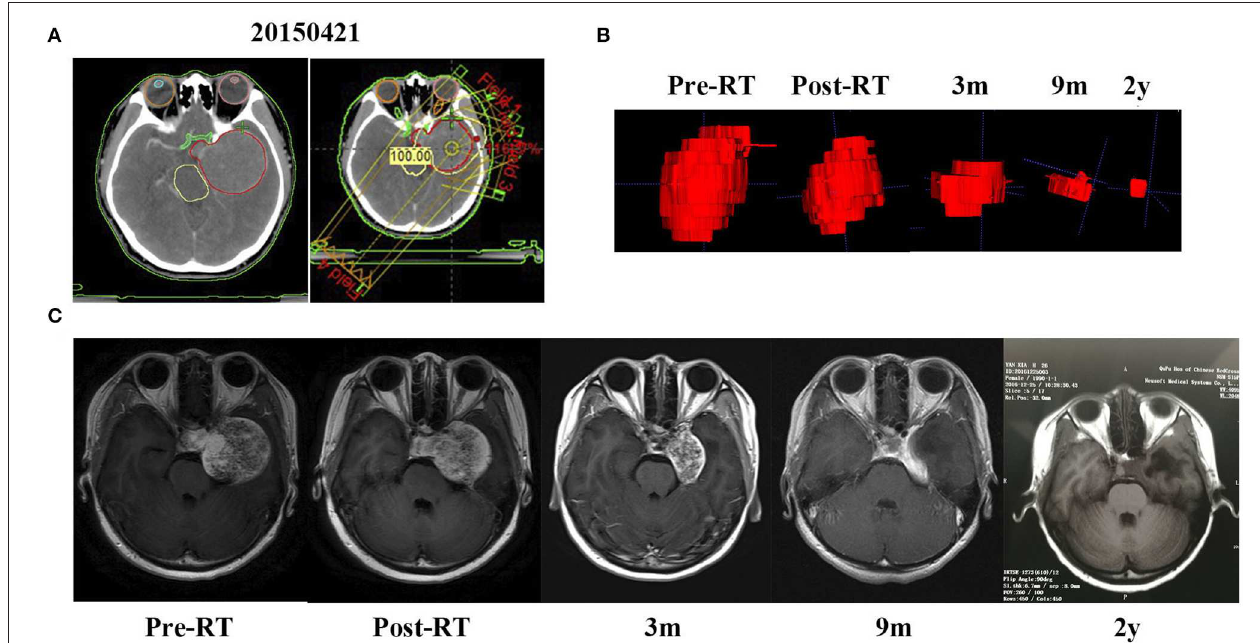
FIGURE 1 | A mass occupying the left cavernous sinus of a 24-year-old woman (patient 1) was shrunk gradually after RT. (A) Treatment plan based on CT scan. (B) The 3D imaging of the mass before RT and at a different time of follow up after RT. (C) MRI scan before RT, the day after RT completion and 3 months, 9 months, and 2 years after